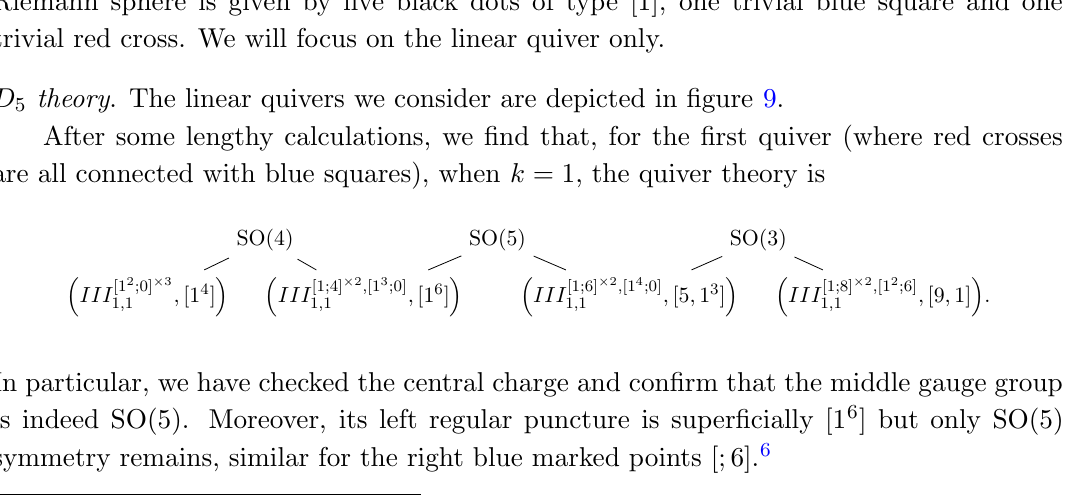
(cid:2) ( k +1) ; [1 N ;0] (cid:0) III [1;2 N (cid:0) 2] k;